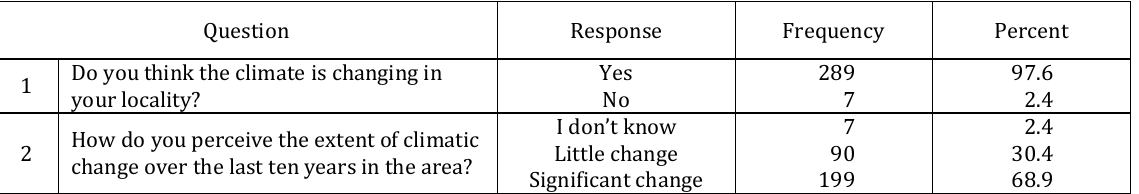
Table 3. Perceptions of farmers about the occurrence and trends of climate change (Source: survey, April